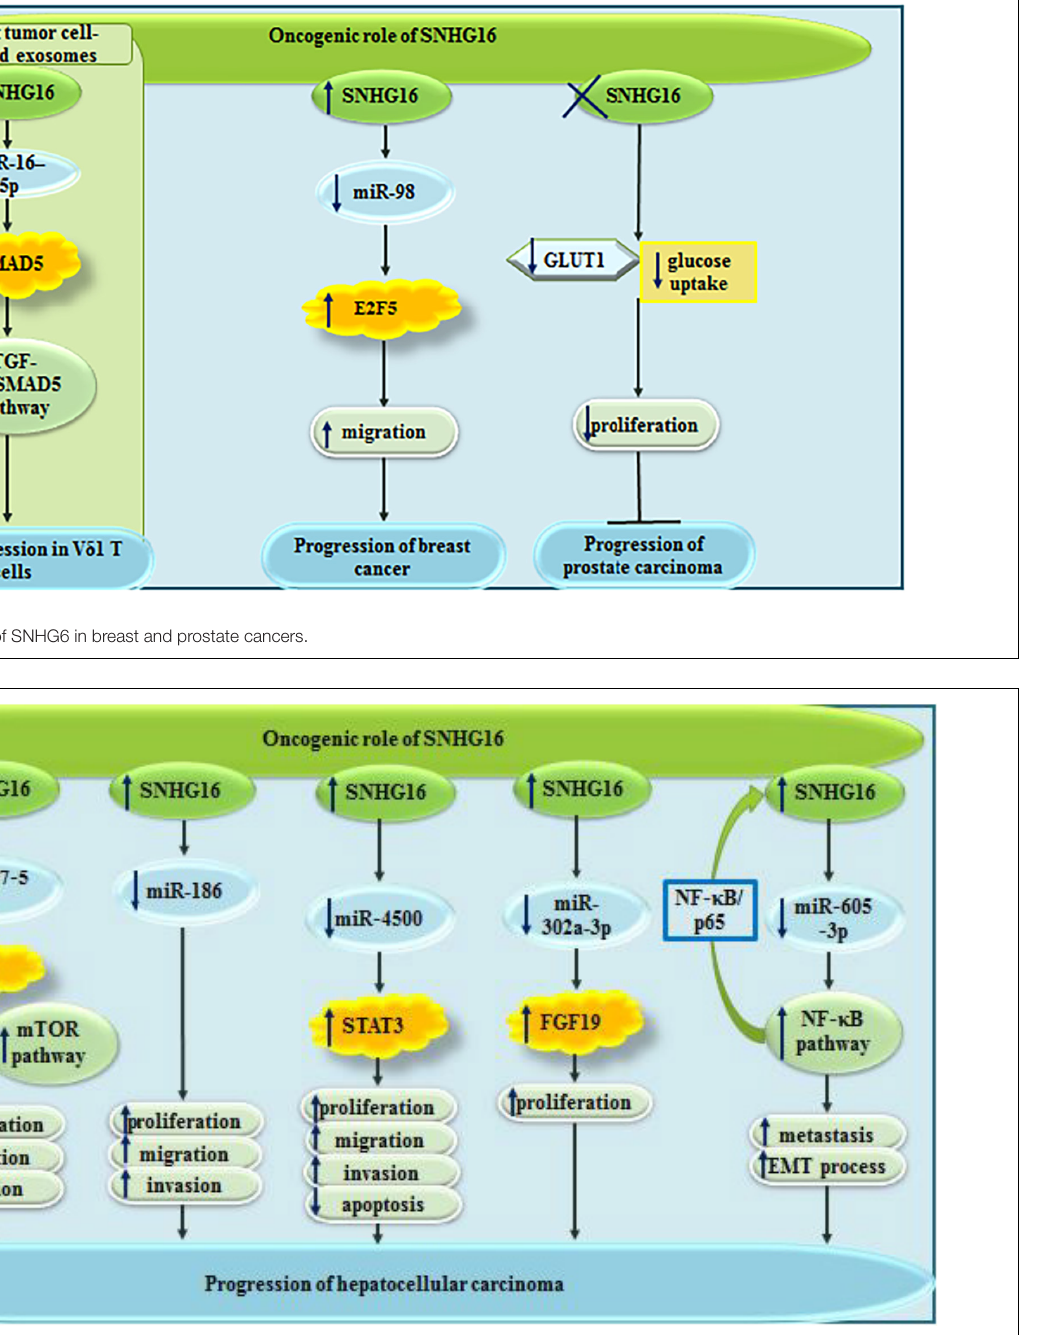
FIGURE 3 | Oncogenic roles of SNHG16 in hepatocellular carcinoma via sponging miR-17-5p, miR-186, miR-4500, miR-302a-3p, and